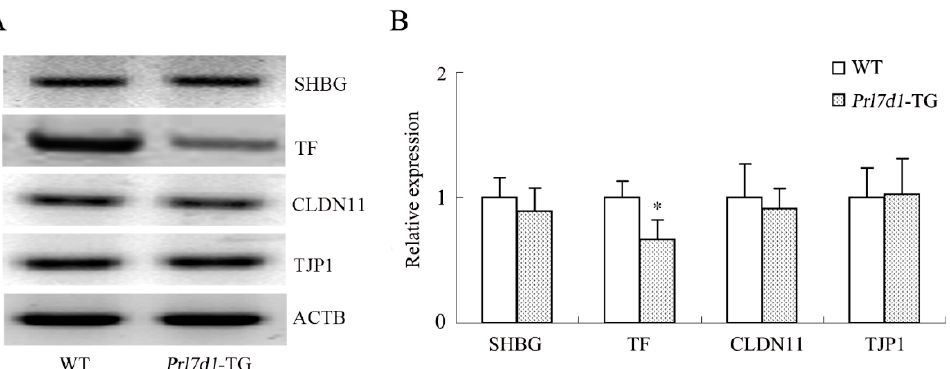
Figure 6. Western blot analyses of the SHBG, TF, CLDN11 and TJP1 in the testes of wild-type (WT) and Prl7d1 transgenic ( Prl7d1 -TG) mice. ( A ) Representative western immunoblots; ( B ) The relative expression levels of the proteins were determined using densitometric analyses of the data that were normalized against the ACTB signal ( n = 6). The protein level in the control group was set to one. Each bar represents the mean ± SD. * p < 0.01 compared to the WT group.